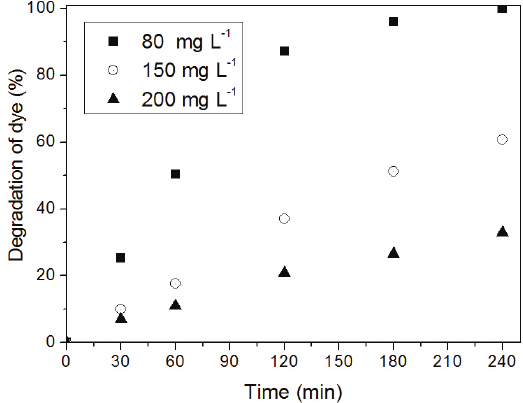
Figure 5. Photocatalytic activity of the ZnAl different initial dye